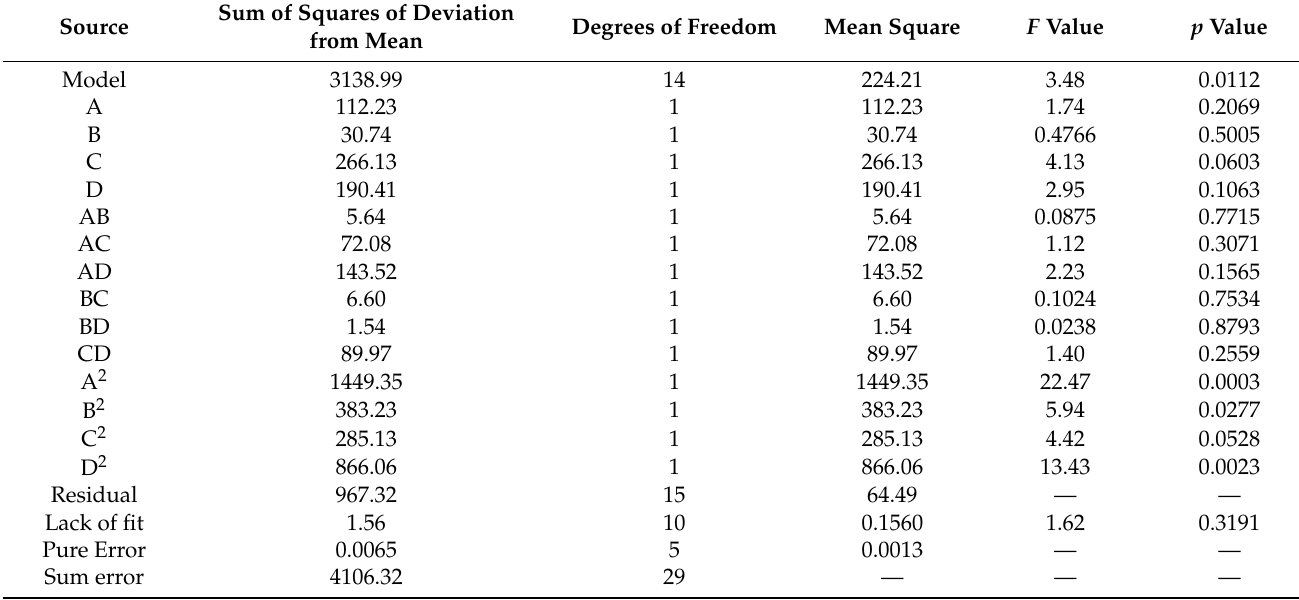
Table 4. Analysis of variance for carbohydrates